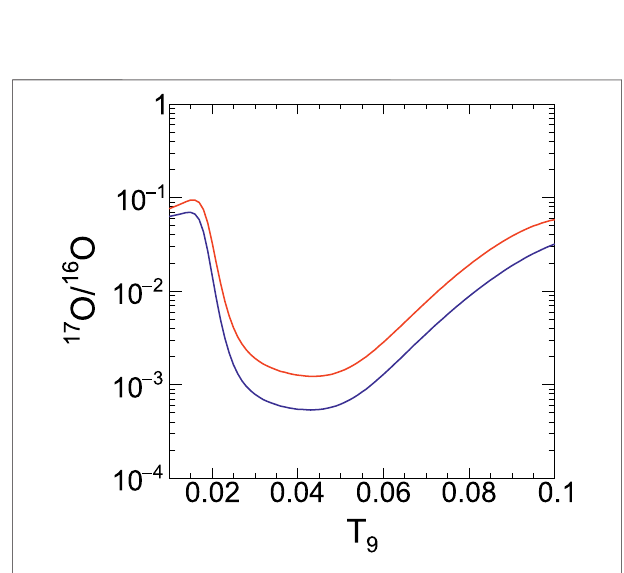
FIGURE 3 | 17 O/ 16 O equilibrium values as a function of temperature computed by using reaction rates of set A (red line) and set B (blue line). See Table 1 and the text for more details. Only results obtained for recommended values of the reaction rates are shown because nucleosynthesis calculations have been run employing only recommended